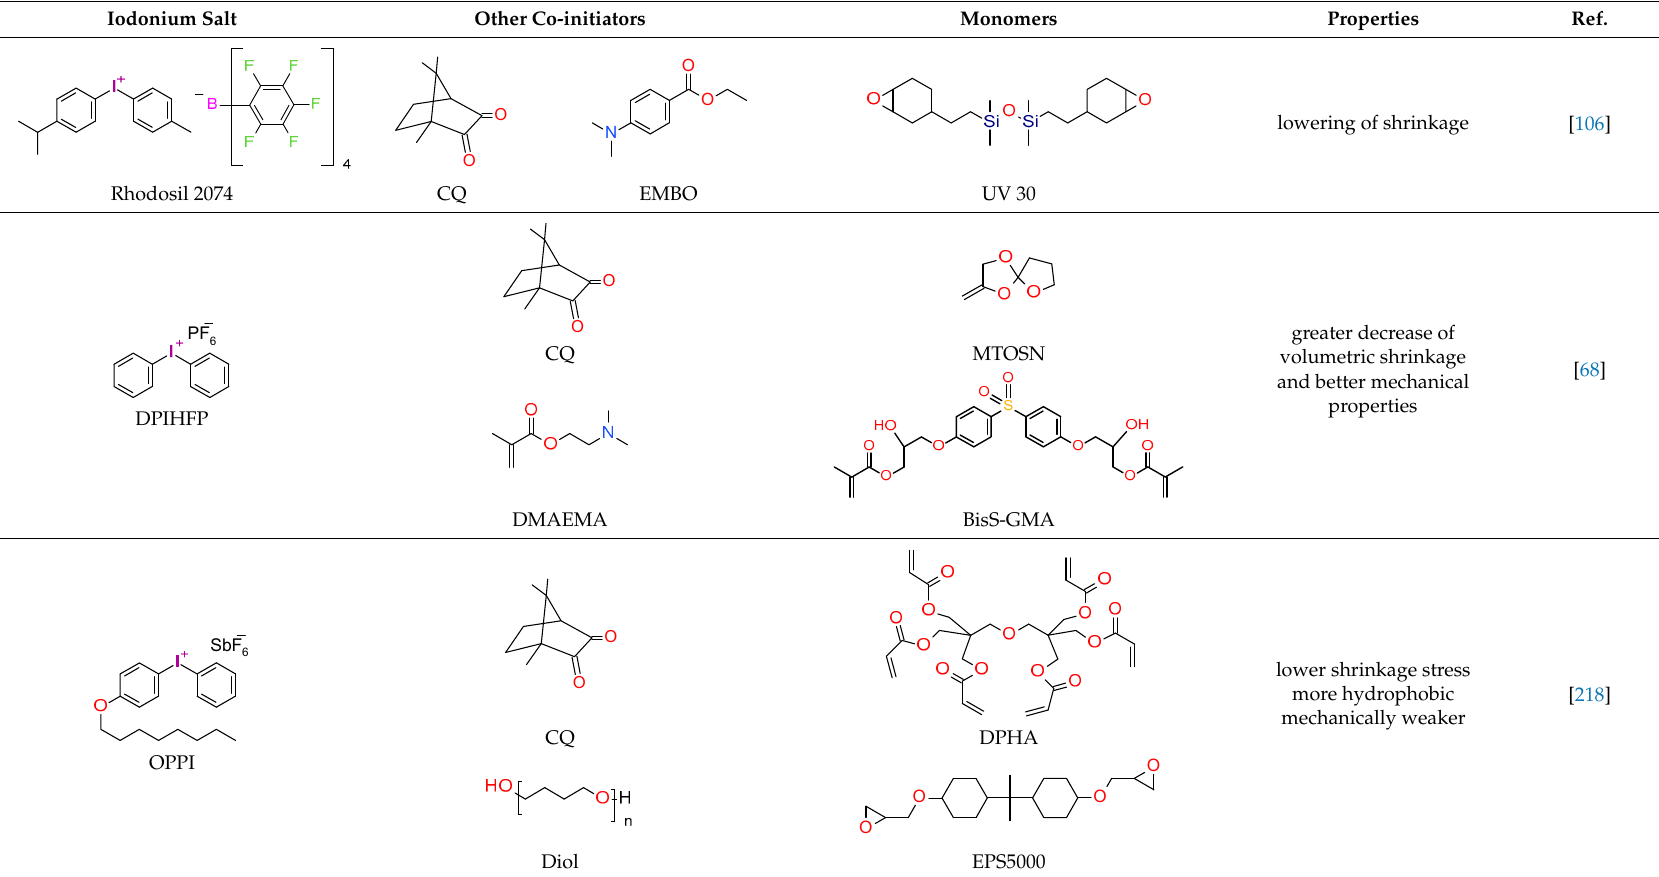
Table 5. Summary of the photoinitiating systems consisting of iodonium salt for cationic and IPN photopolymerization used in a dental application. Iodonium Salt Other Co-initiators Monomers